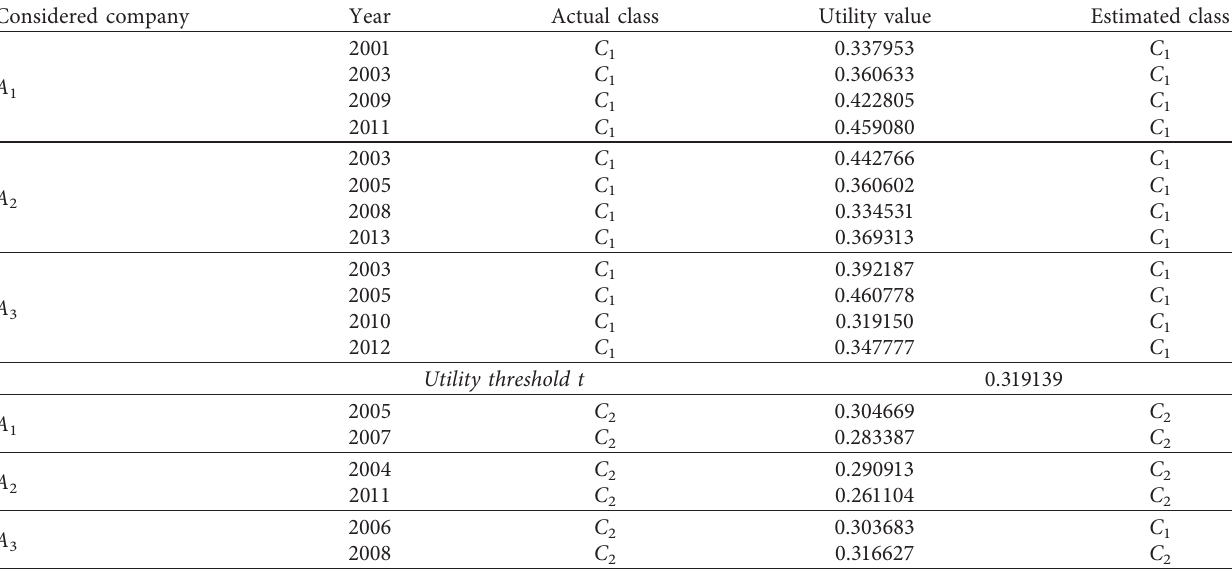
Table 6: Classification results using the single UTADIS method (training dataset).